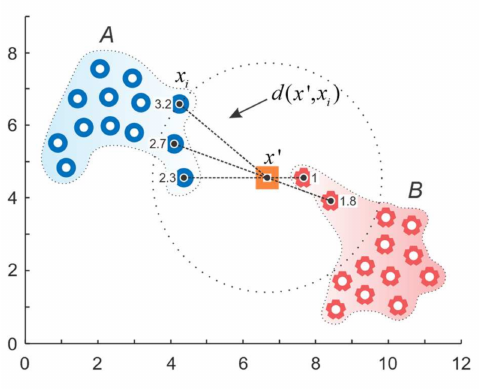
Figure 14. Weighted KNN.